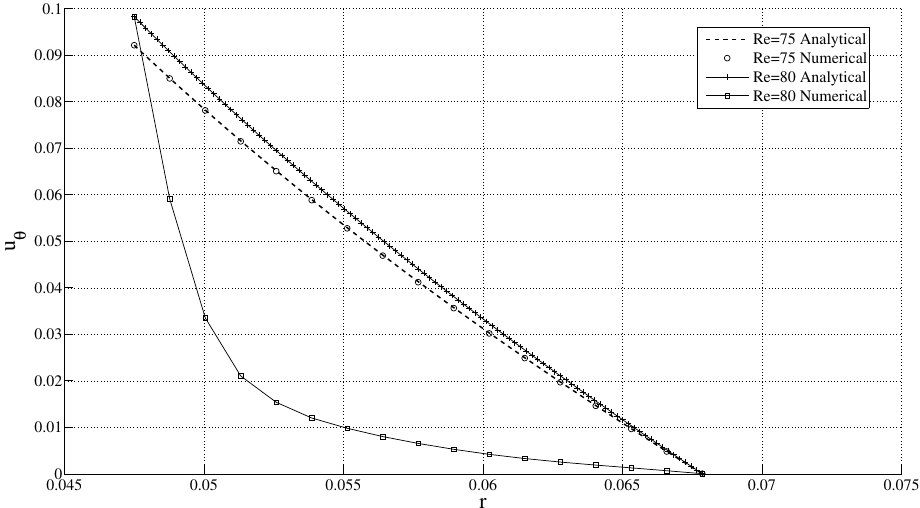
Figure 7. Variation of the azimuthal velocity with radius for different Re for the constant angular speed case.